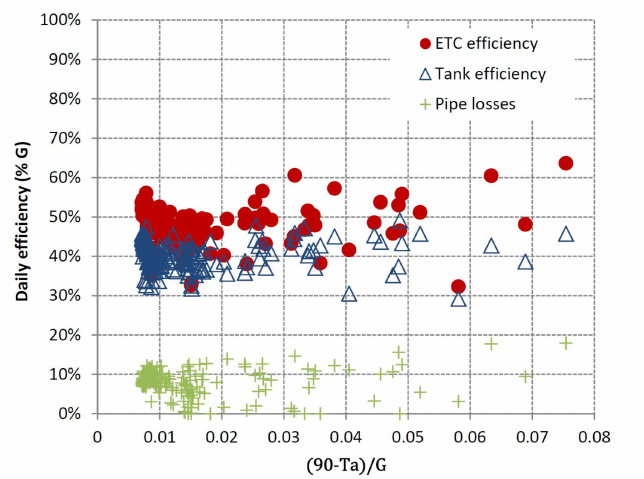
Figure 4. Average daily efficiency of the collector, efficiency of the system and percentage of losses.